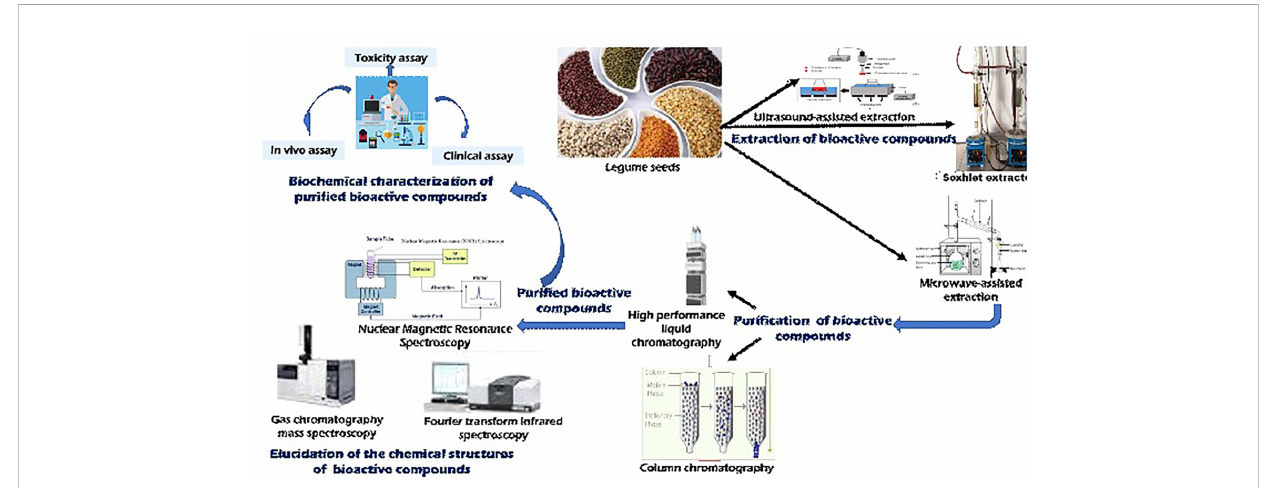
FIGURE 4 Extraction, characterization, and puri fi cation methods for legume seed